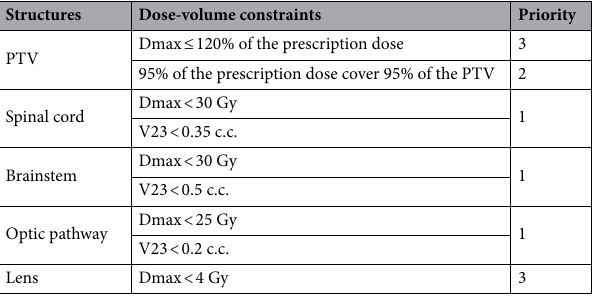
Table 2. Planning objectives for the target and organs at risk. Dmax the maximal point dose (0.0035 cc or less) of the structures, V23 the volume of the organ at risk that receiving more than 23